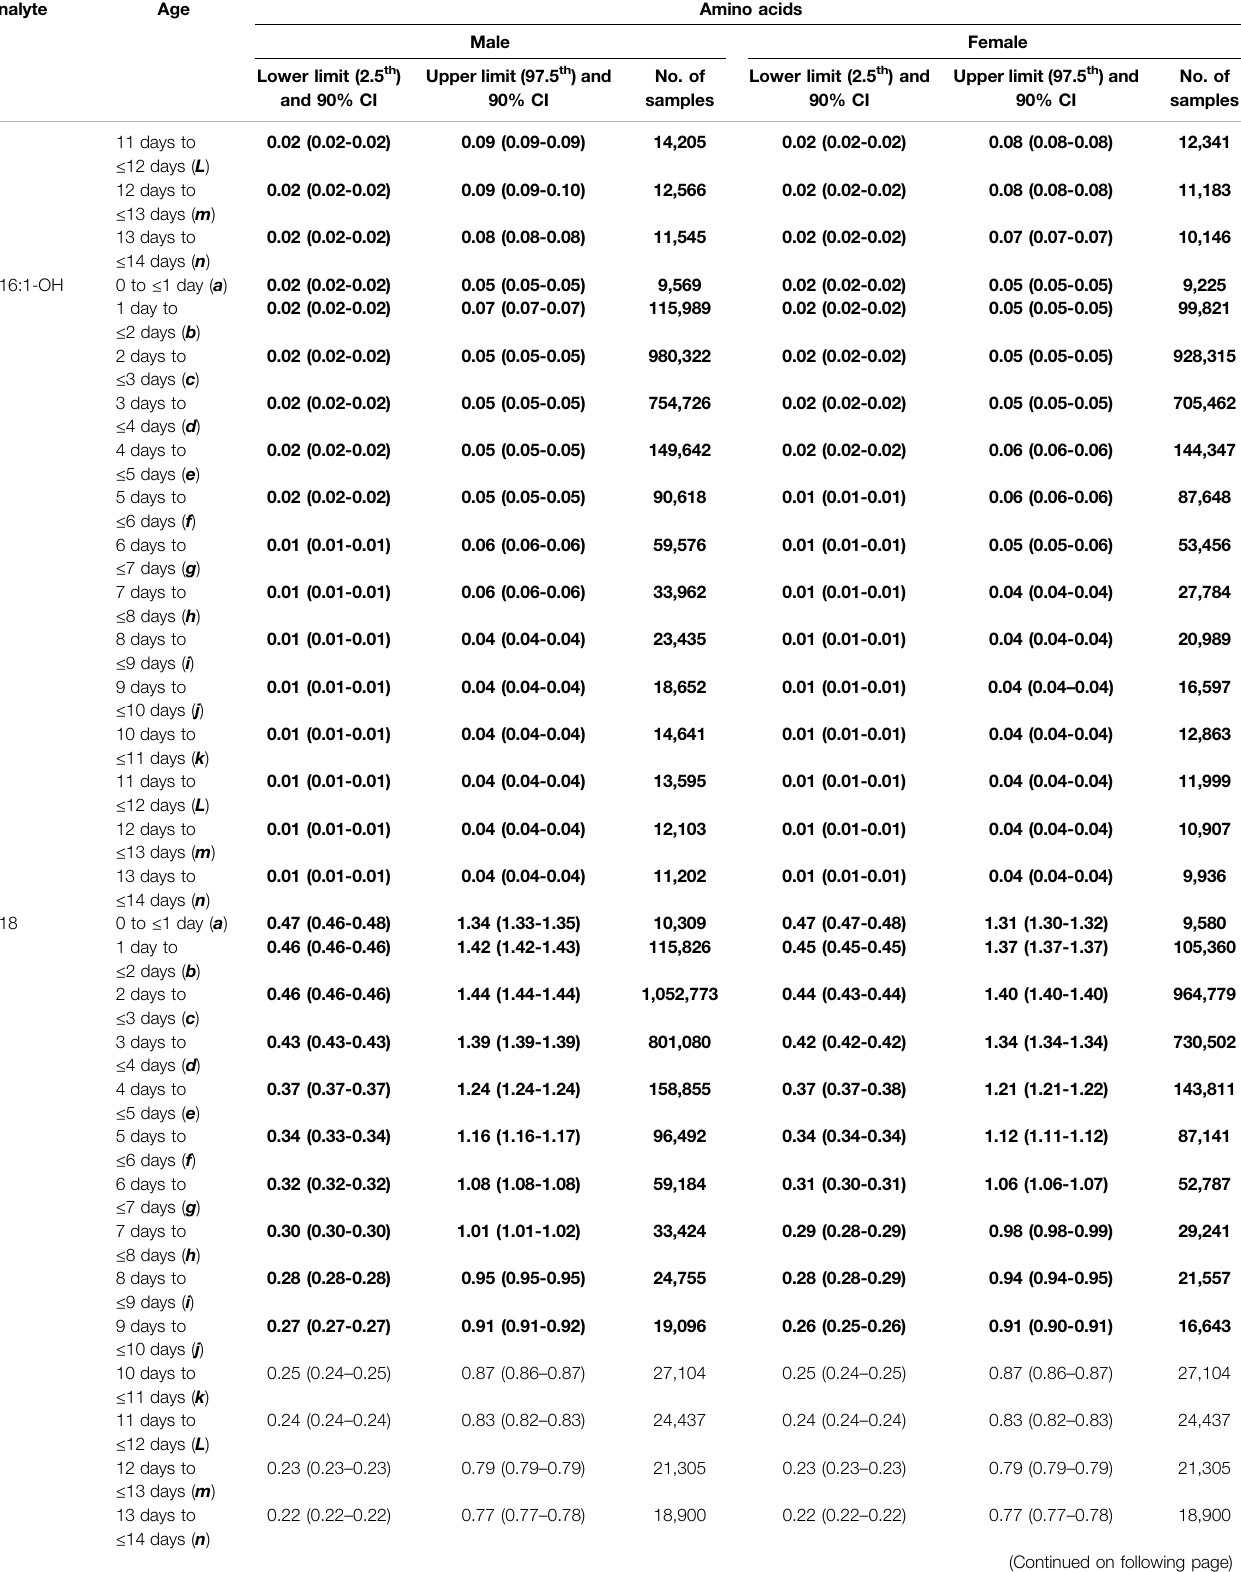
TABLE 2 | ( Continued ) The Reference intervals partitioned by each day and sex for 35 MS/MS NBS biomarkers ( μ